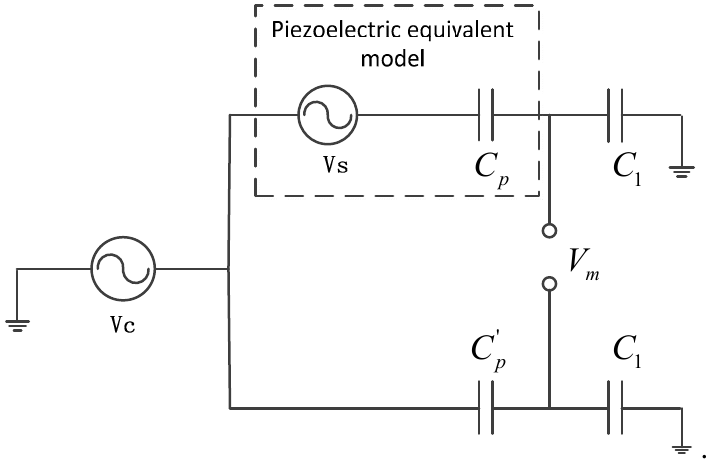
Figure 1. Equivalent circuit of original self-sensing piezoelectric actuation.